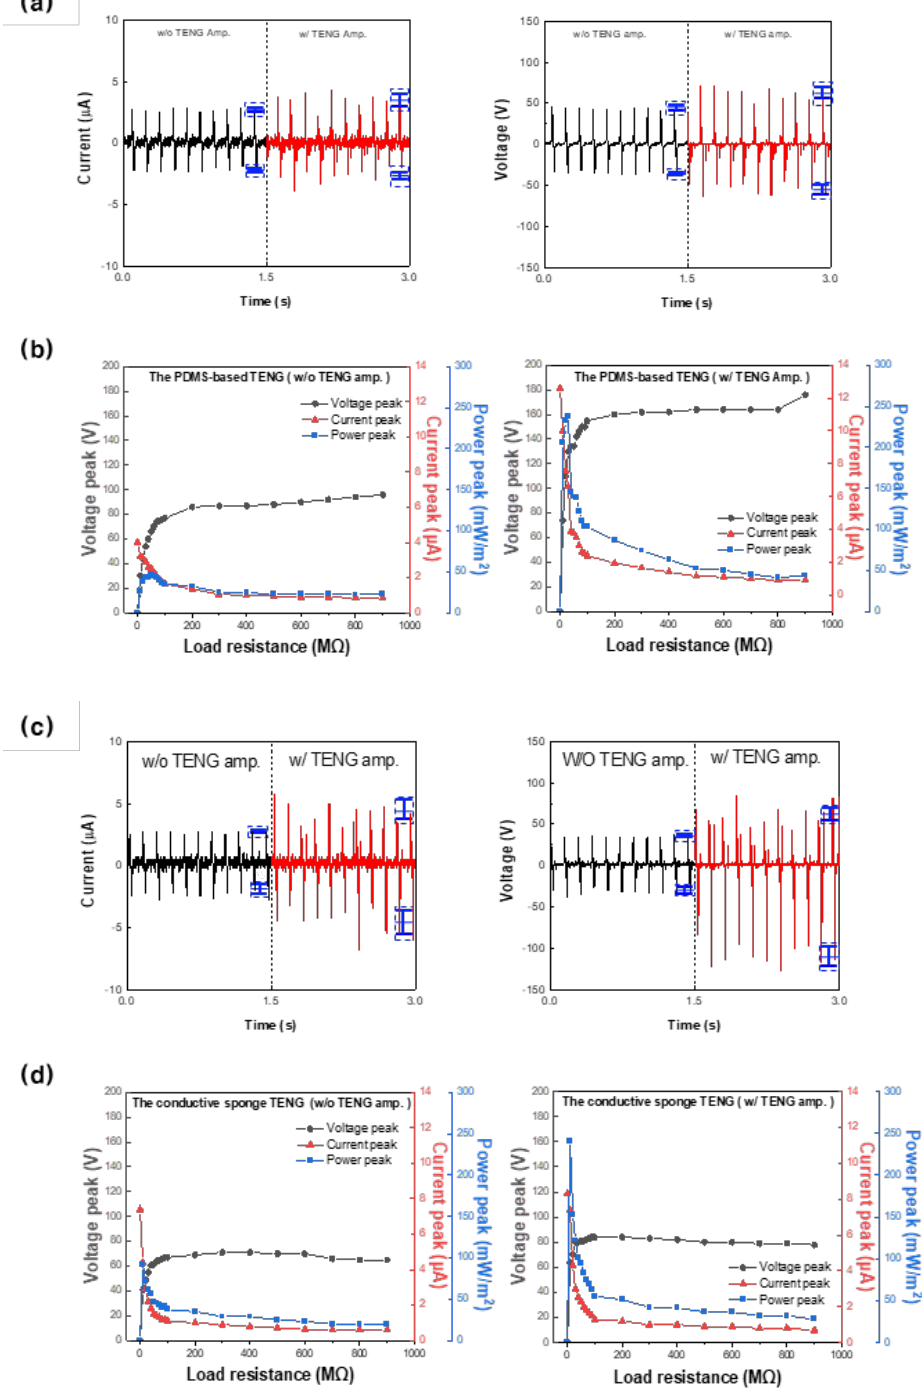
Figure 5. Comparison of outputs with and without the amplifier in a TENG specimen: ( a ) graphs of the current and voltage outputs of the PDMS − based TENG specimen; ( b ) graphs of the voltage peak, current peak, and power peak of the PDMS − based TENG specimen according to load resistance; ( c ) graphs of the current and voltage outputs of the conductive sponge TENG specimen; ( d ) graphs of the voltage peak, current peak, and power peak of the conductive sponge TENG specimen depending on load